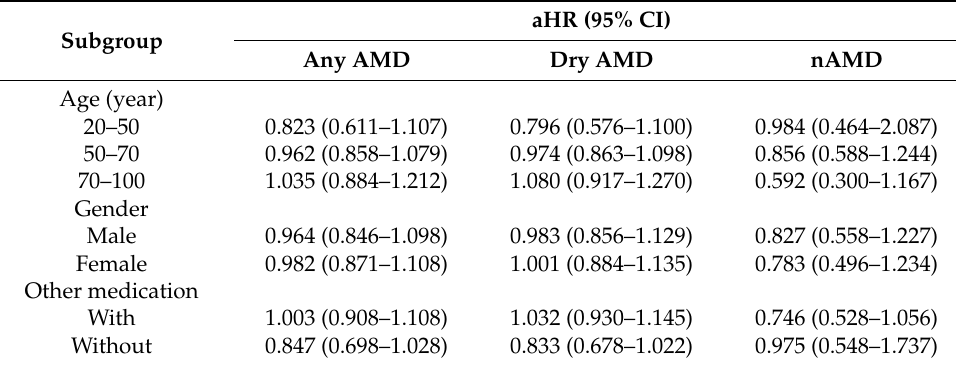
Table 5. Sensitivity analysis for the incidence of age-related macular degeneration.